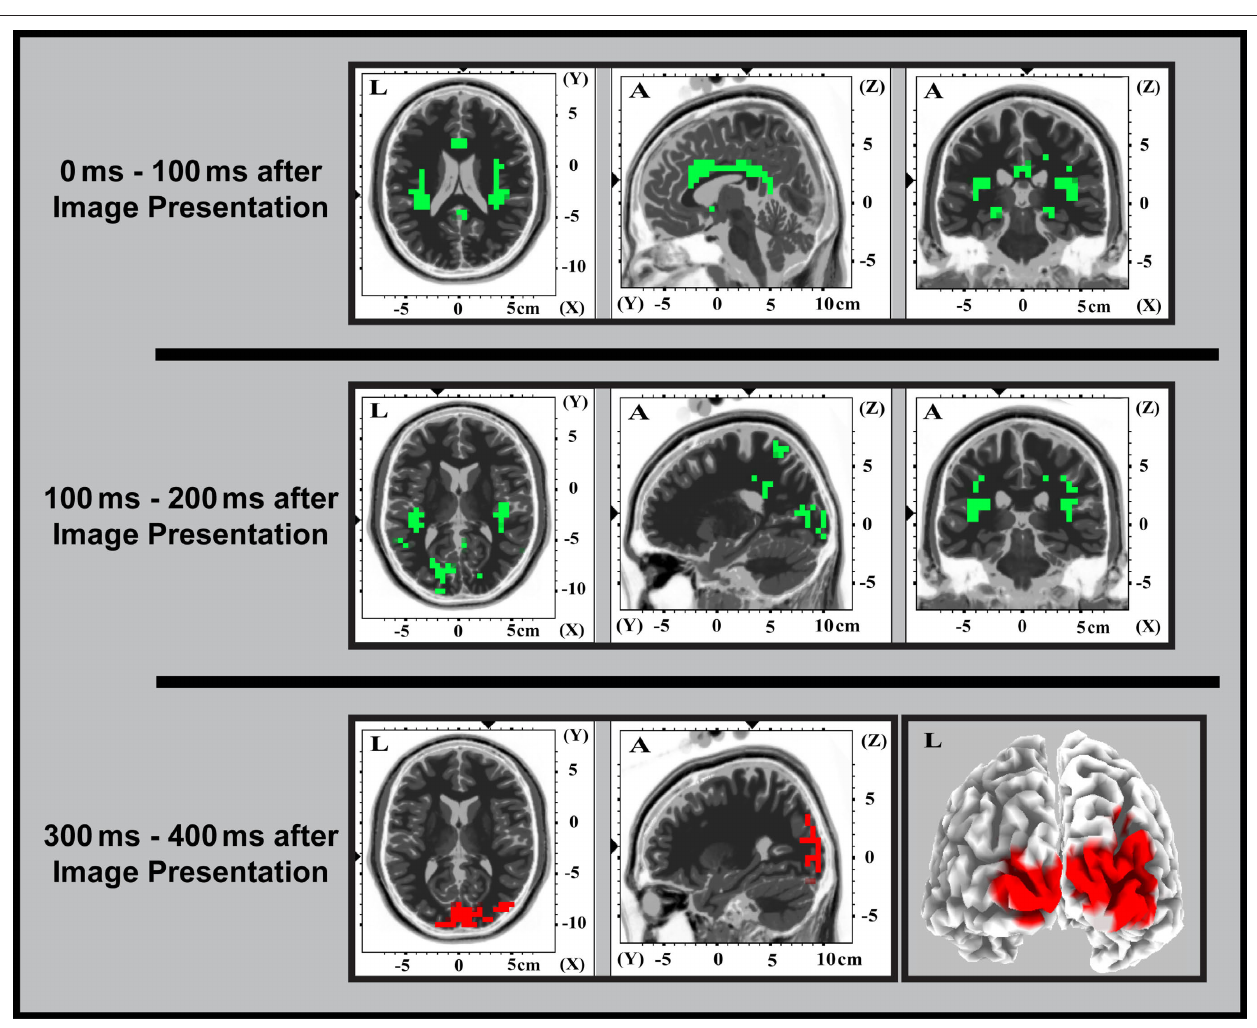
FIGuRE 5 | Source localized (sLORETA) EEG activation differences. Differences for [correct > tool] > [incorrect > tool] are shown in red and those for [incorrect > tool] > [correct > tool] are shown in green. All activations shown were statistically significant at P < 0.05. Each row corresponds to a unique contrast as